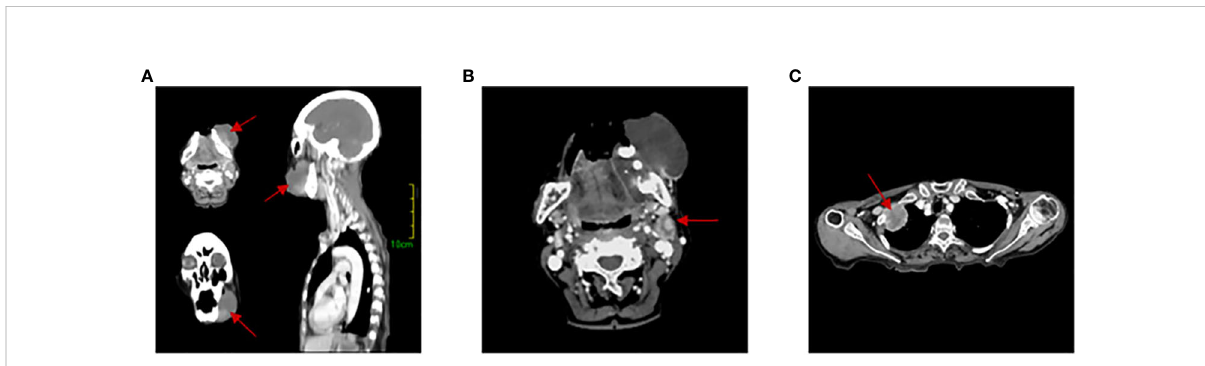
FIGURE 1 Computed tomography (CT) scans. (A) 3D image of gingival tumor. (B) Lymph node metastasis area. (C) Lung metastases lesion. The red arrow indicates the location of the